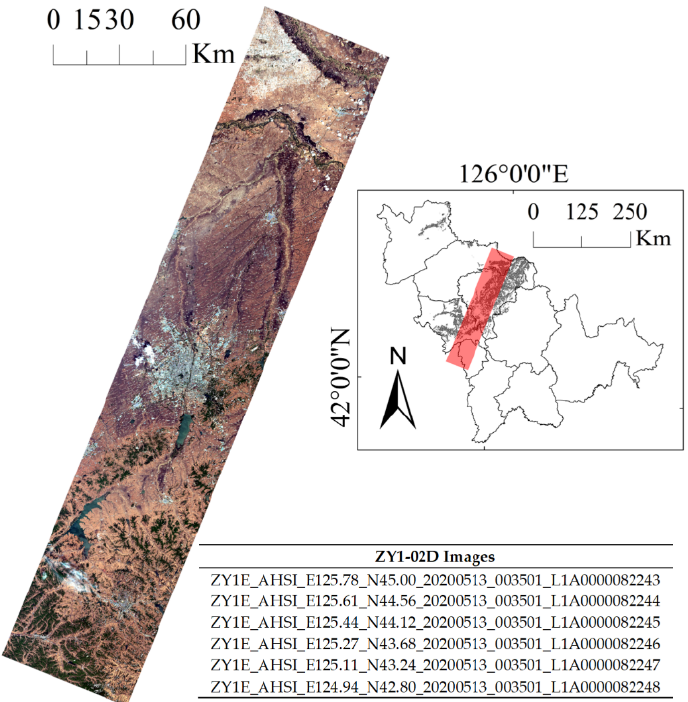
Figure 3. ZY1-02D images acquired on the study area of the typical black soil belt in Jilin province, China (experimental raw images were acquired on 13 May 2020), (displayed with R: band35_687.9896 nm, G: band17_533.5523 nm, B: band7_447.0988 nm).